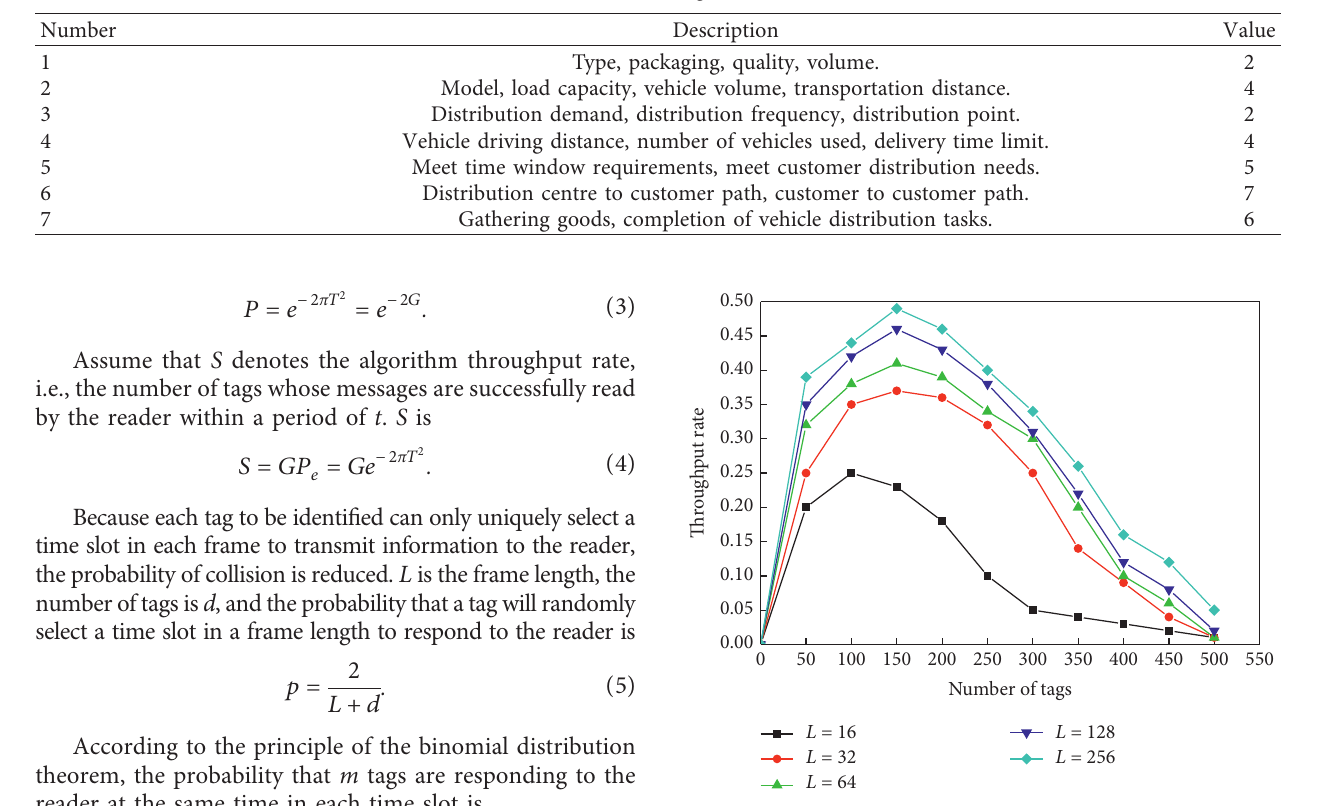
Figure 2: Frame length vs. throughput rate.